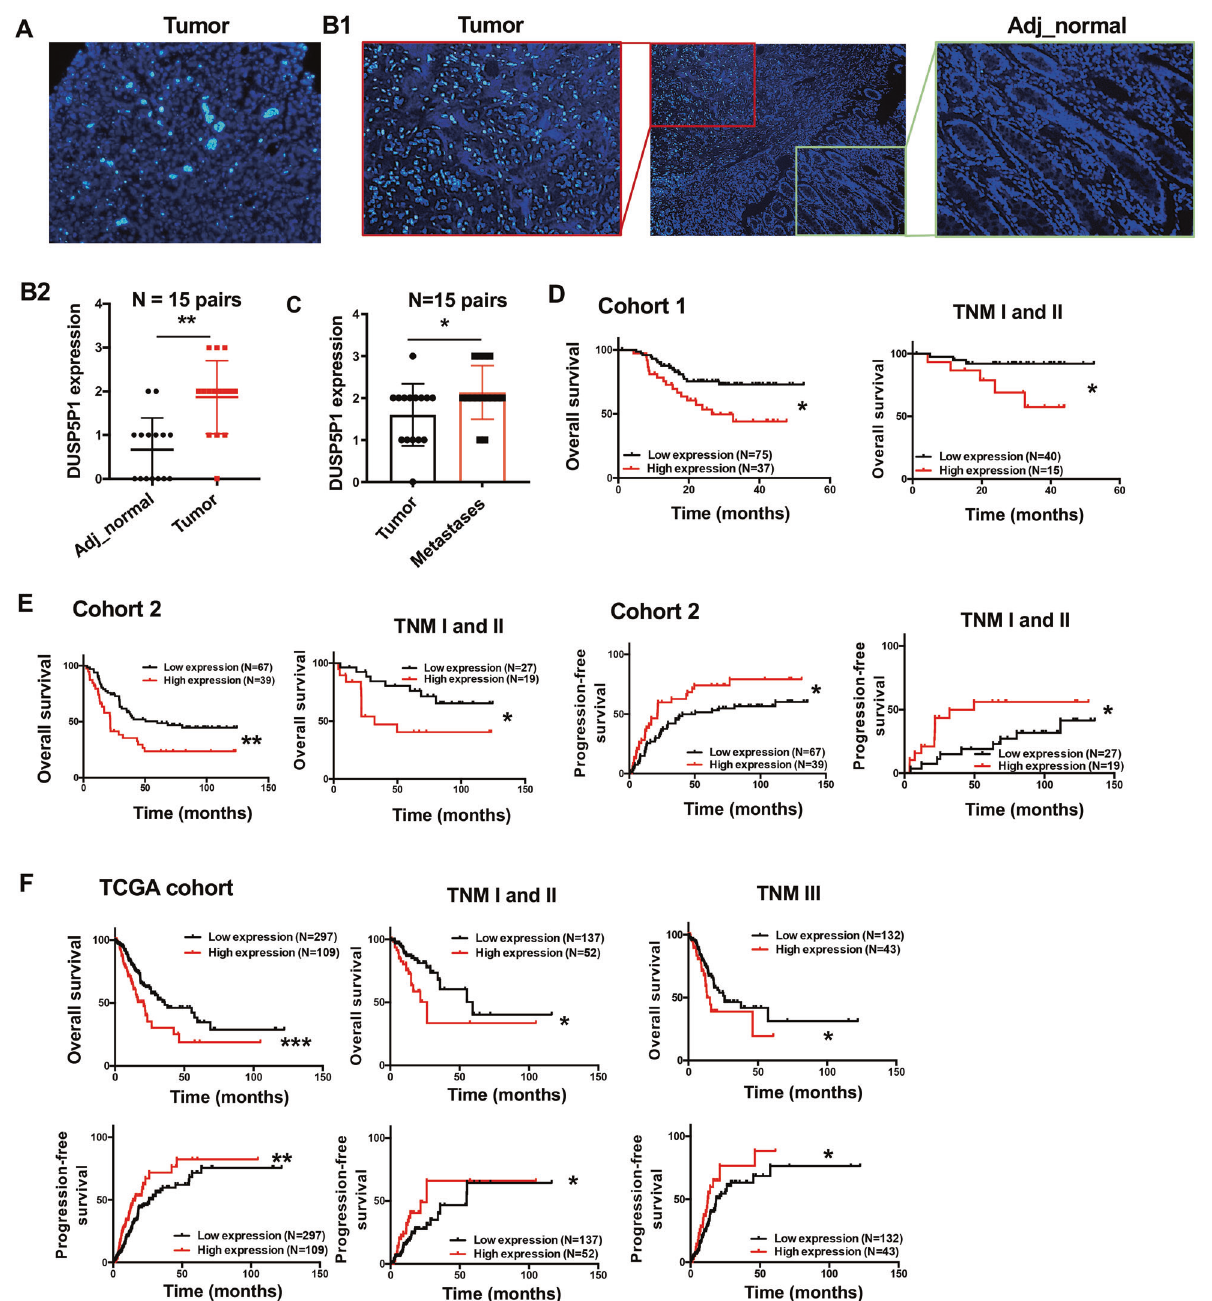
Fig. 1 DUSP5P1 upregulation in primary gastric cancers are associated with poor prognosis of gastric cancer patients. A Representative images of DUSP5P1 positive staining by RNA FISH in GC tissue. B DUSP5P1 expression was signi fi cantly upregulated in gastric tumors as compared to adjacent non-tumor tissues by RNA FISH. C DUSP5P1 expression was upregulated in metastasis lesions as compared to primary tumor tissues. D Kaplan – Meier survival analysis in GC patients with different DUSP5P1 expression status in cohort I. E Kaplan – Meier survival analysis in GC patients with different DUSP5P1 expression in cohort II. F Kaplan – Meier survival analysis in GC patients with different DUSP5P1 expression in TCGA dataset. * P < 0.05, ** P < 0.01, *** P < 0.001, **** P <